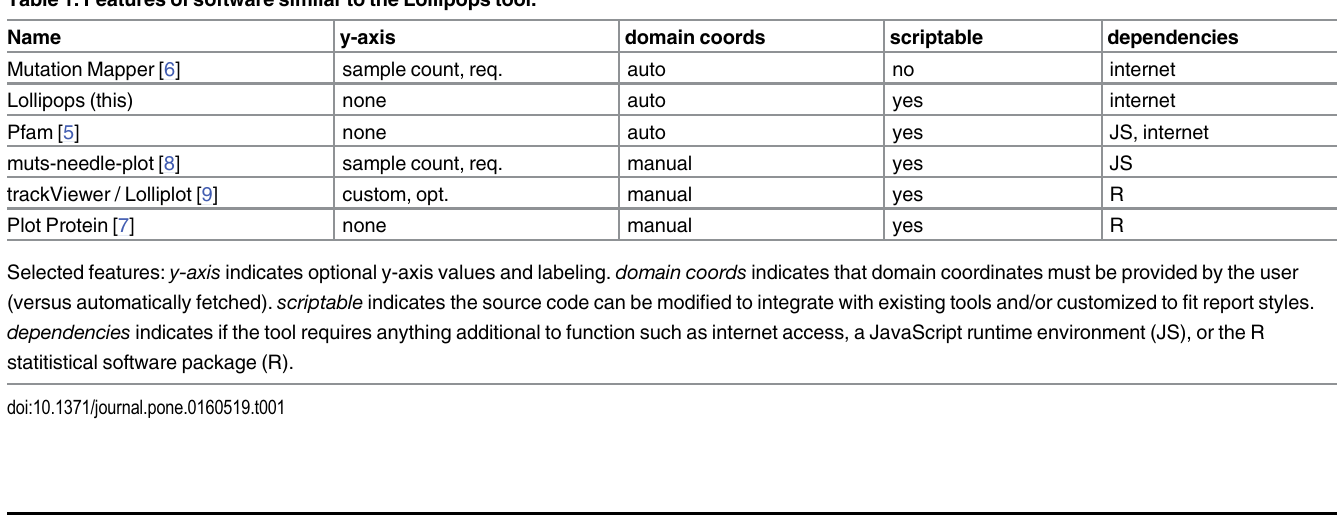
Table 1. Features of software similar to the Lollipops tool.